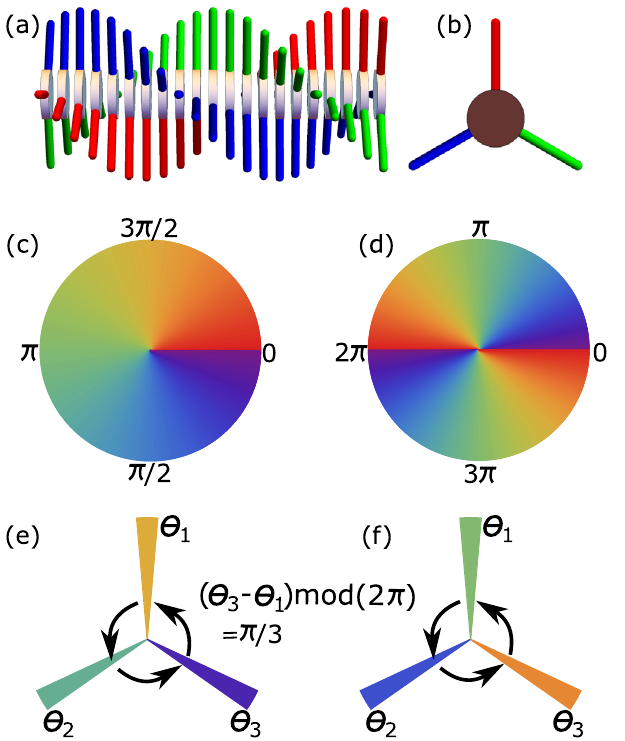
Fig. 1 CNTs and OAM. a CNTs have the same structure as a chain of coaxial parallel molecules with helical misorientation. A chain of centrosymmetric molecules exhibits a structural helicity in which each molecule is misoriented relative to its neighbors. Exciton hopping can still occur between nearest-neighbor arms of the same color. b Molecule with C 3 symmetry. c Clockwise 2 π phase variation for OAM = 1 and d counterclockwise 4 π phase variation for OAM = − 2. Applied to the molecule in b , by taking the phases of c and d at the positions of the arms, twisted light with e OAM = 1 and f OAM = − 2 leads to the same phase difference between neighboring arms modulo 2 π .